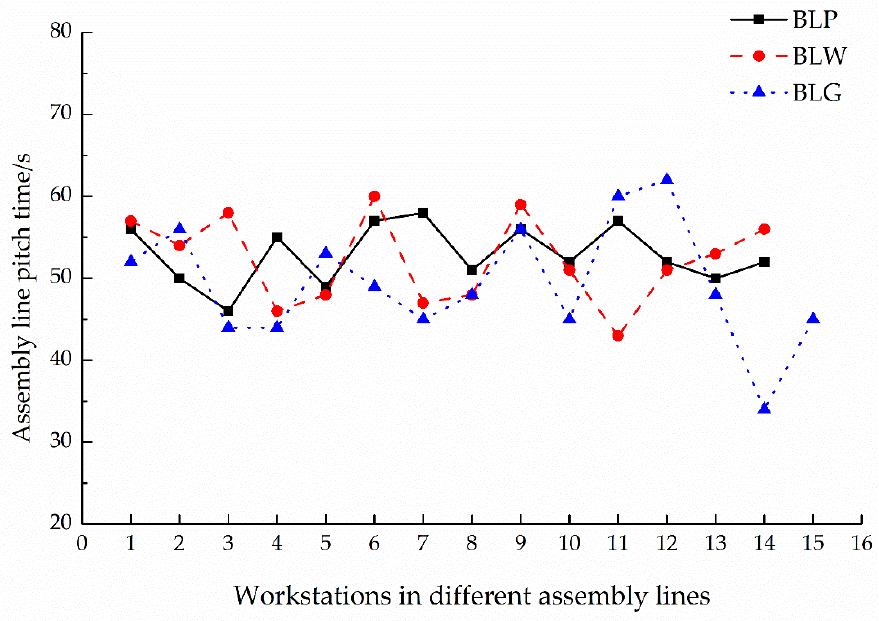
Figure 8. Operating time of workstations in different assembly lines.